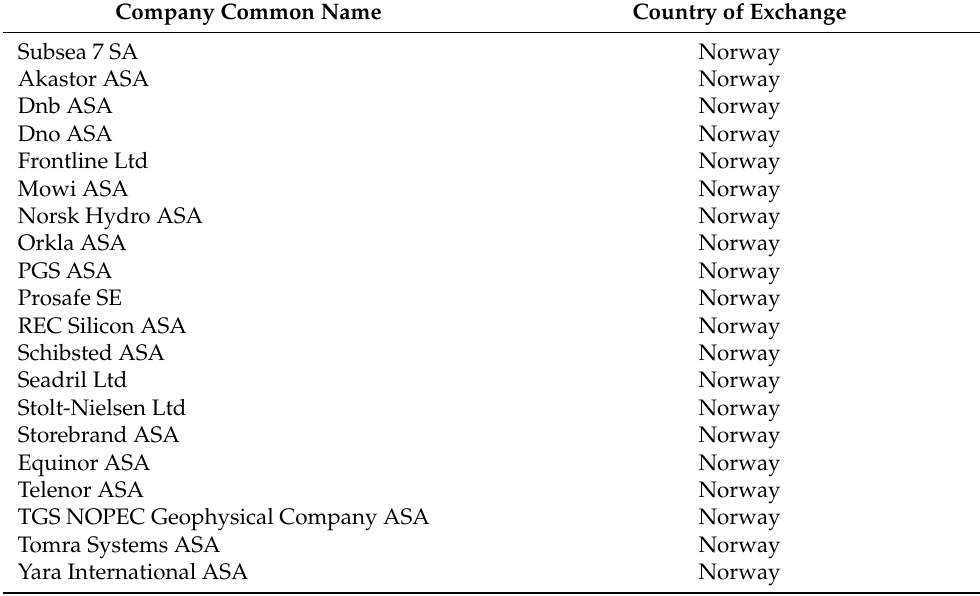
Table A1. Sampled